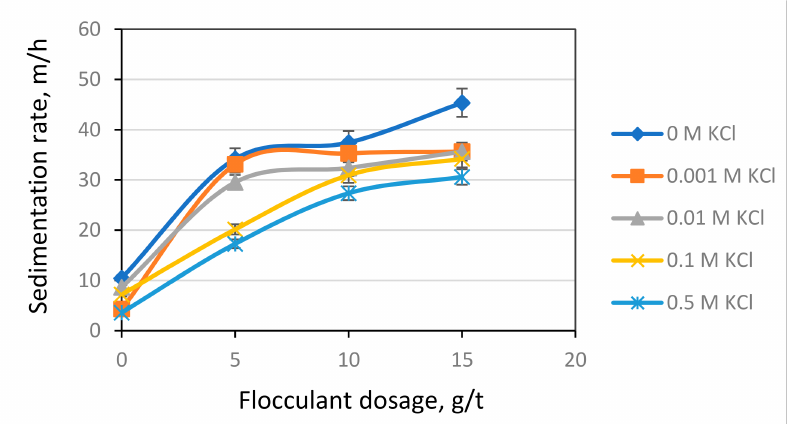
Figure 8. Sedimentation rate in relation to the flocculant dose Magnafloc 338 in industrial